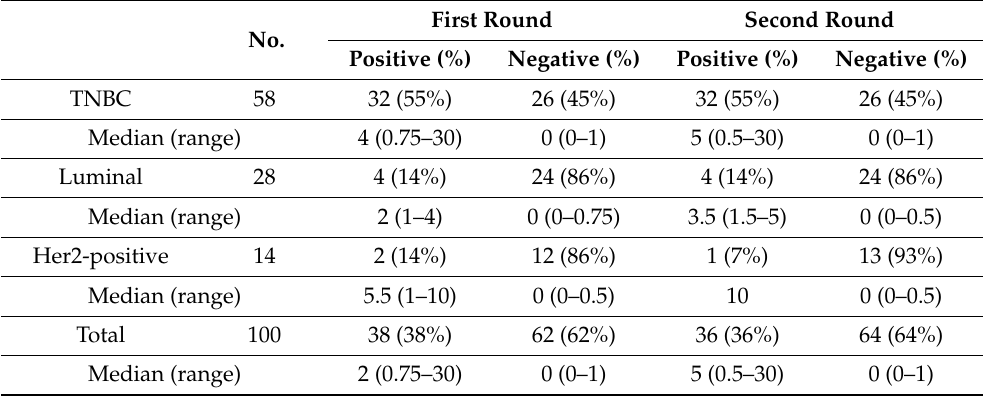
Table 1. Frequency of PD-L1 positivity in breast cancer in both rounds, stratified by the molecular type.